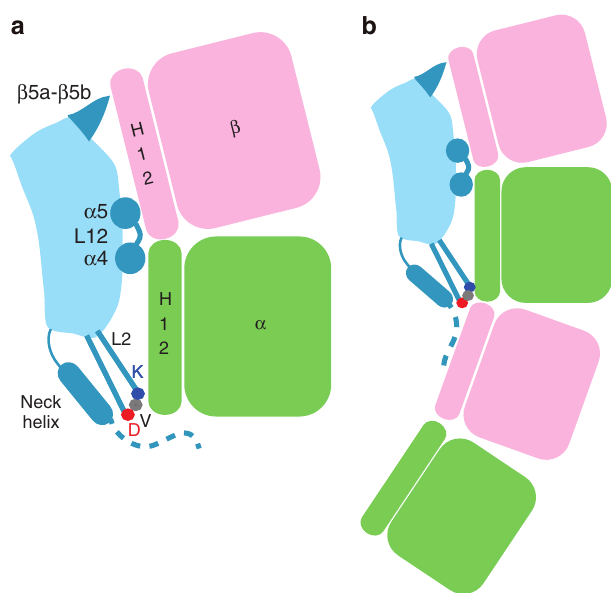
Fig. 6 Models of Kif2C stabilizing curved tubulin(s). a Kif2C stabilizes curved tubulin by interacting in particular with the N-terminal and C-terminal ends of the H12 helices of both tubulin subunits. The tubulin- interacting elements of Kif2C are in darker blue . The KVD motif at the tip of the L2 hairpin is pictured by three dots. The N-terminal part of the short neck region, that is disordered in the structure, is shown as a dashed line . b Model of Kif2C stabilizing a longitudinal assembly of two tubulins that might be the complex that dissociates from microtubule ends during catalytic disassembly 10 . In this model, the second tubulin molecule is stabilized through interactions with the L2 hairpin tip of Kif2C-(sN+M), and in particular by the aspartate residue ( red dot ) of the KVD motif, and with the N-terminal part of its neck